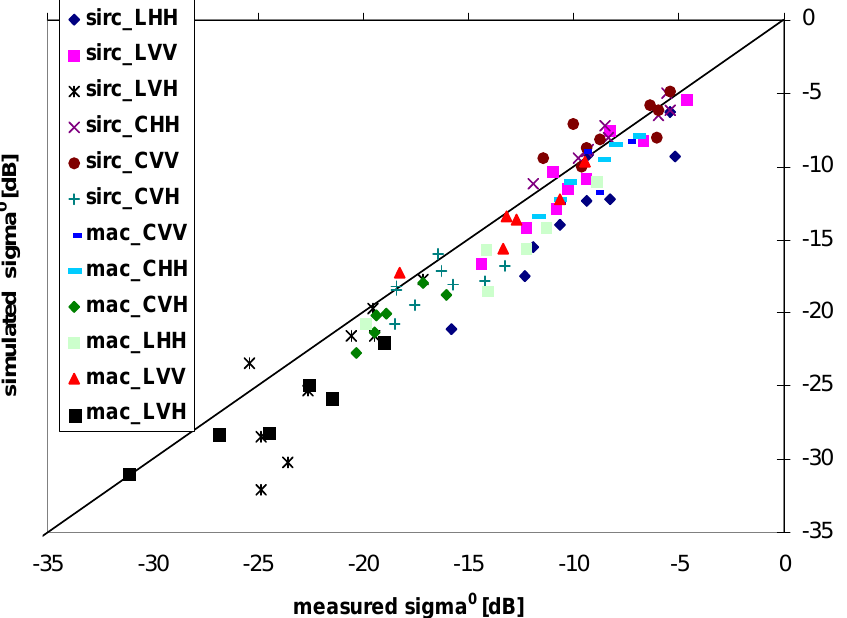
Figure 6 . Scatterplot of SEM simulated versus measured backscattering coefficient (  ° ) for MAC and SIR-C polarimetric data. Data are reported without any bias